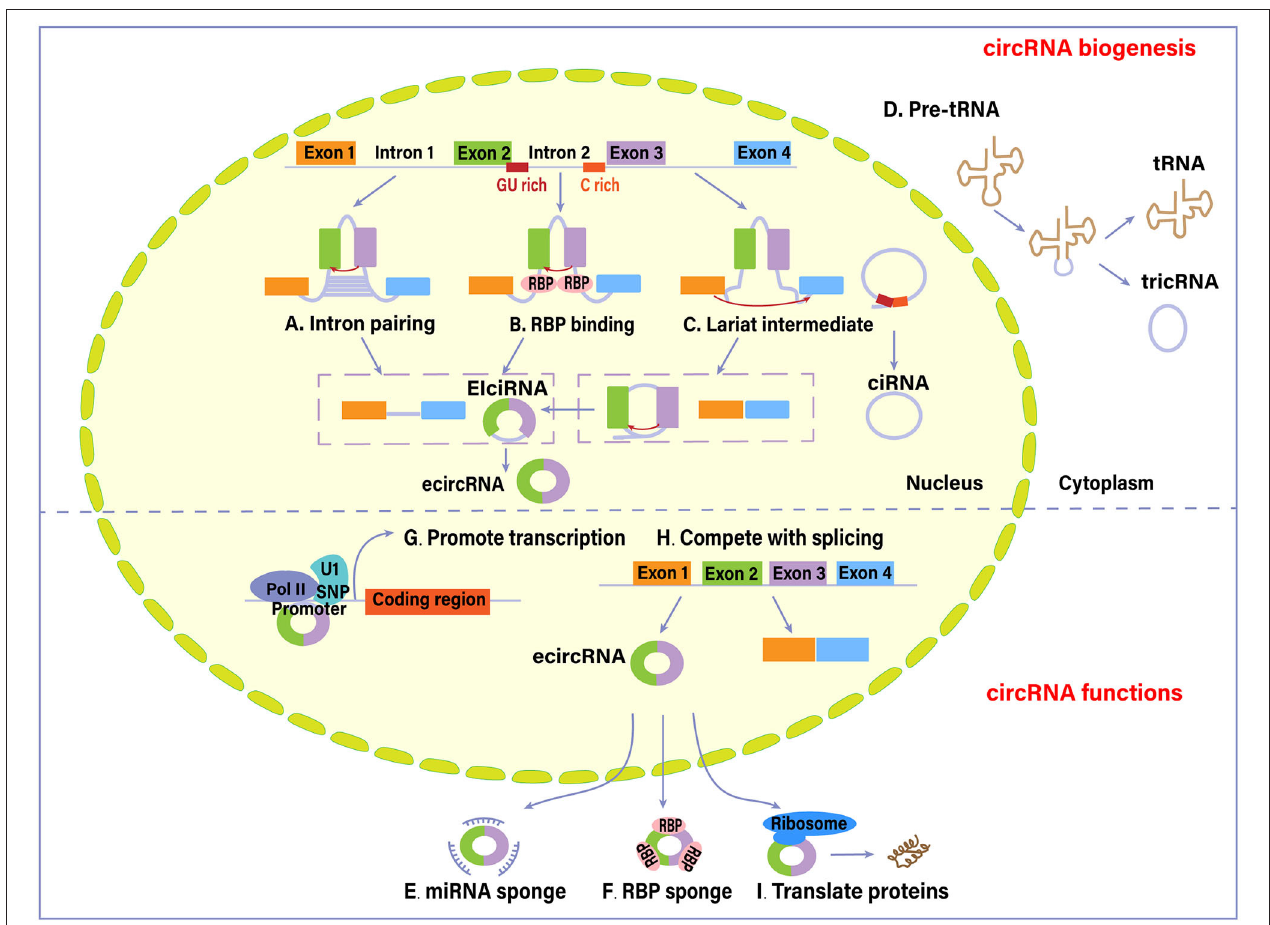
FIGURE 1 | Biogenesis and functions of circular RNAs (circRNAs). Four different mechanisms mainly account for the biogenesis of circRNAs: (A) intron pairing pathway, (B) RNA-binding proteins (RBPs)-associated pathway, (C) lariat-driven pathway, and (D) synthesized from introns spliced from pre-tRNA. As of functions, (E) circRNAs can sequester and absorb miRNAs to regulate the function of miRNAs. (F) circRNAs interact with RBPs and thus regulate their cellular localization and activity. (G) circRNAs interact with RNA polymerase II (Pol II) or U1 small nuclear ribonucleoprotein (snRNP) in the promoter region to promote the transcription of their host genes. (H) circRNAs compete with canonical splicing of pre-mRNAs to regulate gene expression. (I) circRNAs are also capable of encoding proteins. EIci-RNA, exon-intron circRNA; ecircRNA, exonic circRNA ( Hansen et al., 2013; Chen and Yang, 2015; Li et al., 2015; Wan et al., 2016; Liu et al., 2017; Meng et al., 2017; Noto et al., 2017; Han et al., 2018; Shen et al., 2019; Verduci et al., 2019; Wawrzyniak et al.,